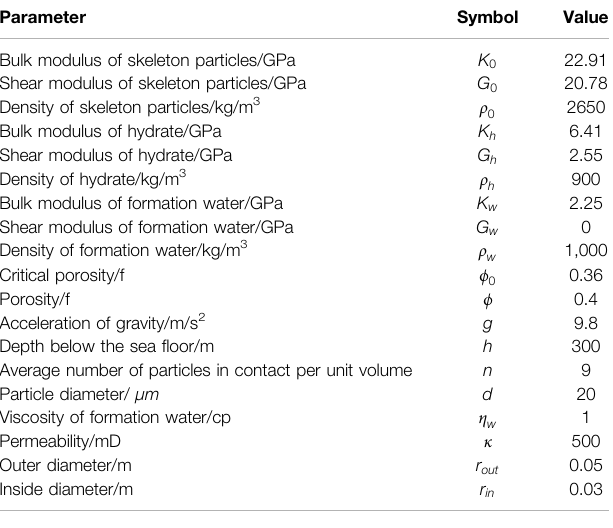
TABLE 1 | Parameters. Parameter